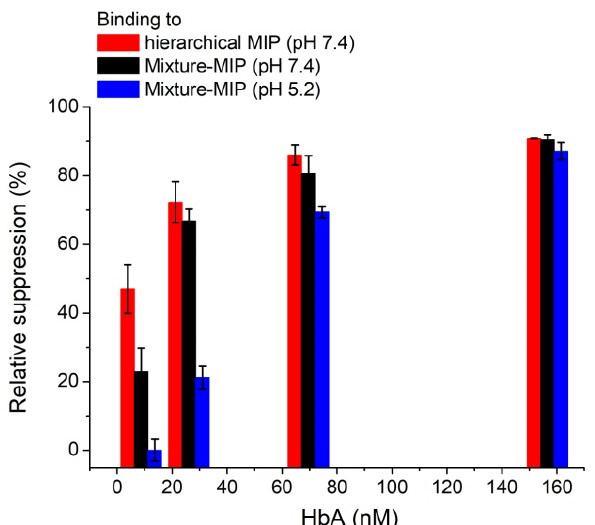
Figure 3. Comparison of the concentration-dependent relative suppression of the SWV signals (peak currents) detected for HbA rebinding to hierarchical MIP (red columns) and mixture-MIPs (black columns) in PBS buffer of pH 7.4, containing 5 mM ferri/ferrocyanide and 10 mM KCl. Measurements performed at pH 5.2 are indicated by blue columns.